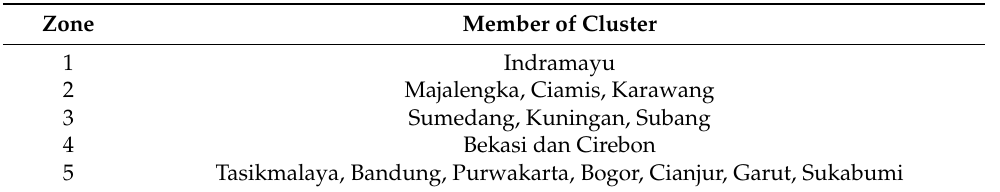
Table 6. The results of zone division in West Java Province use clustering of type I. Zone